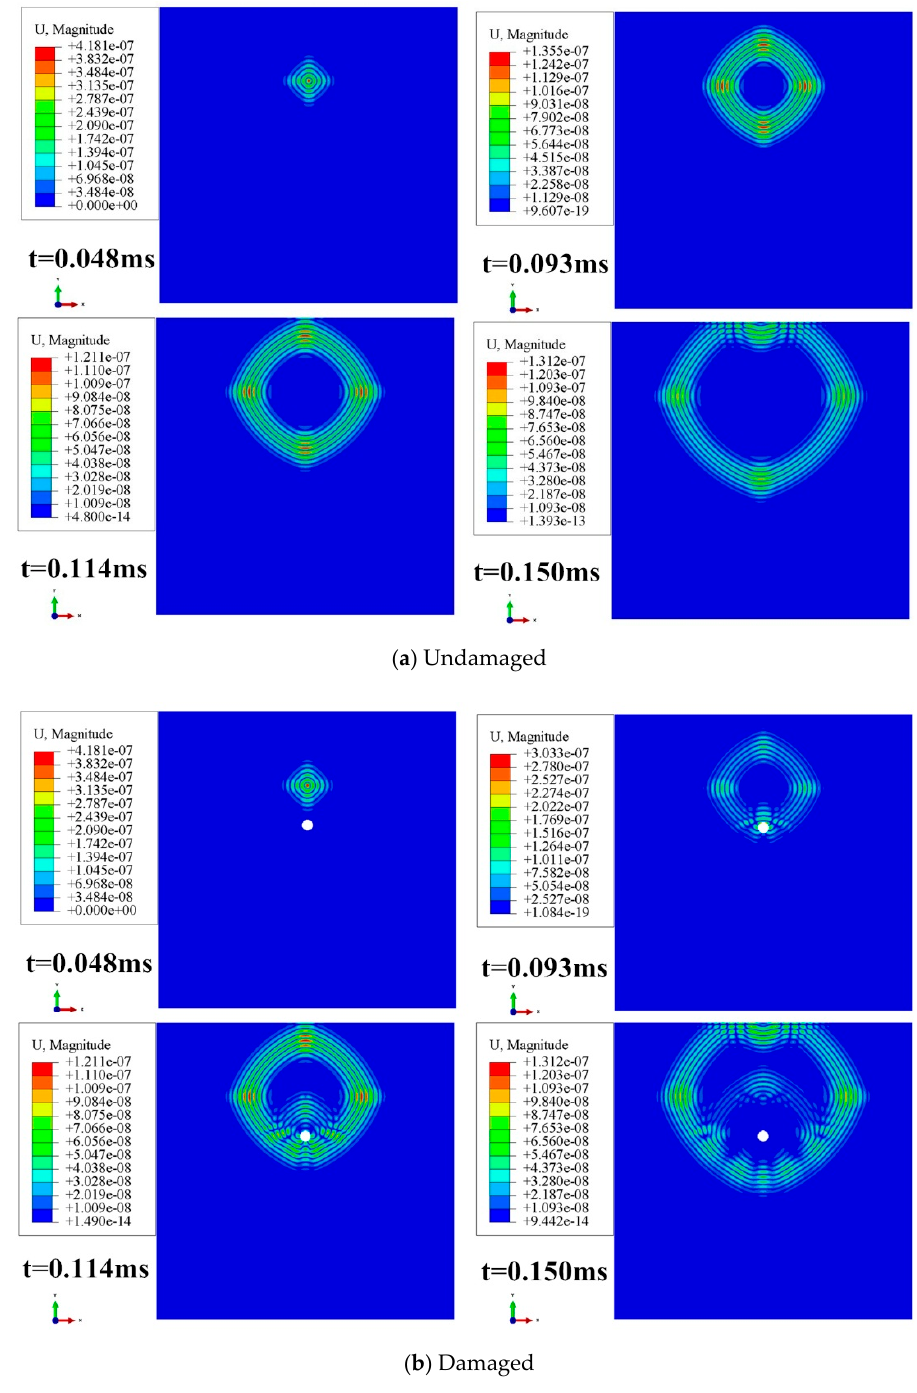
Figure 2. Lamb wave propagation cloud map in carbon fiber reinforced polymer (CFRP).